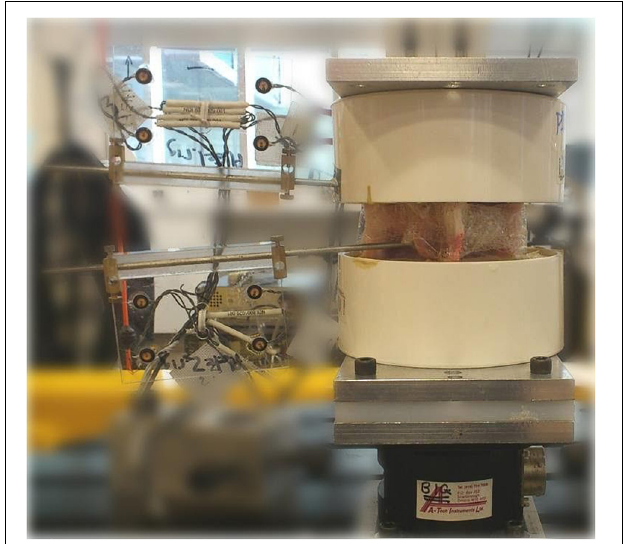
FIGURE 2 | Potted specimen with L4 (bottom pot) fixed to the 6-axis load cell and L3 (upper pot) fixed to a stationary cross